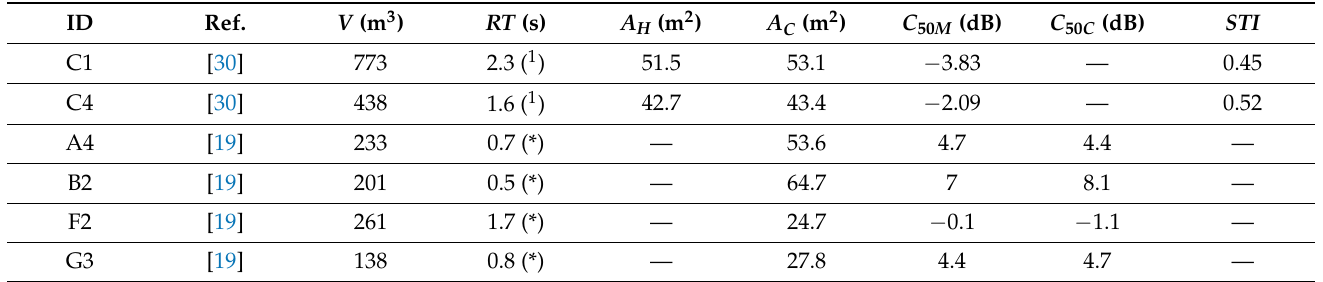
Table 1. Classroom data taken from the authors’ previous work and found in the